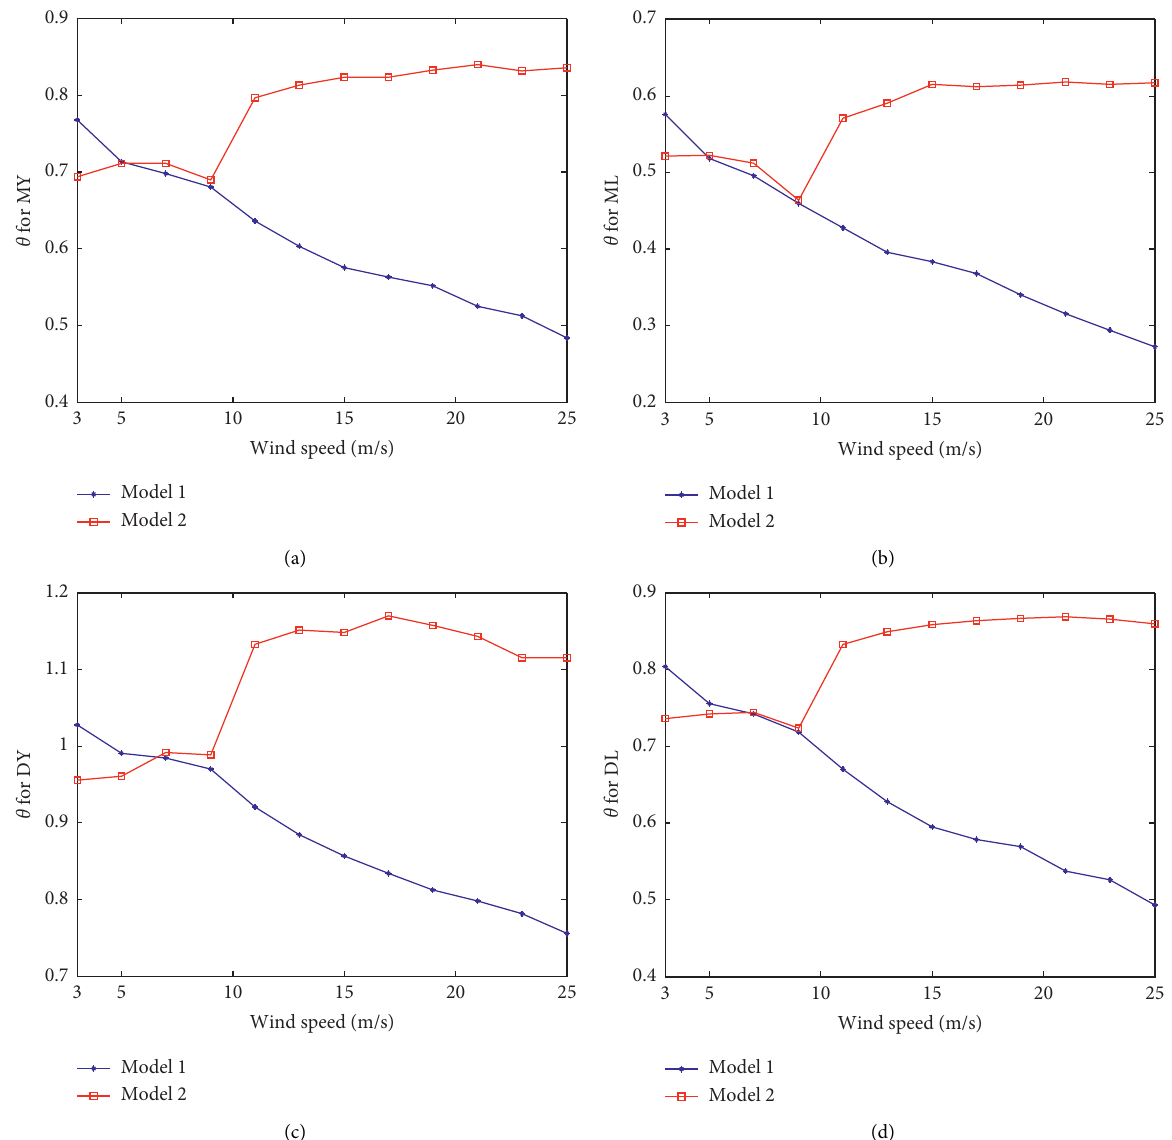
Figure 9: Comparison of the estimated θ with different wind speeds between the two models: (a) MY, (b) ML, (c) DY, and (d)